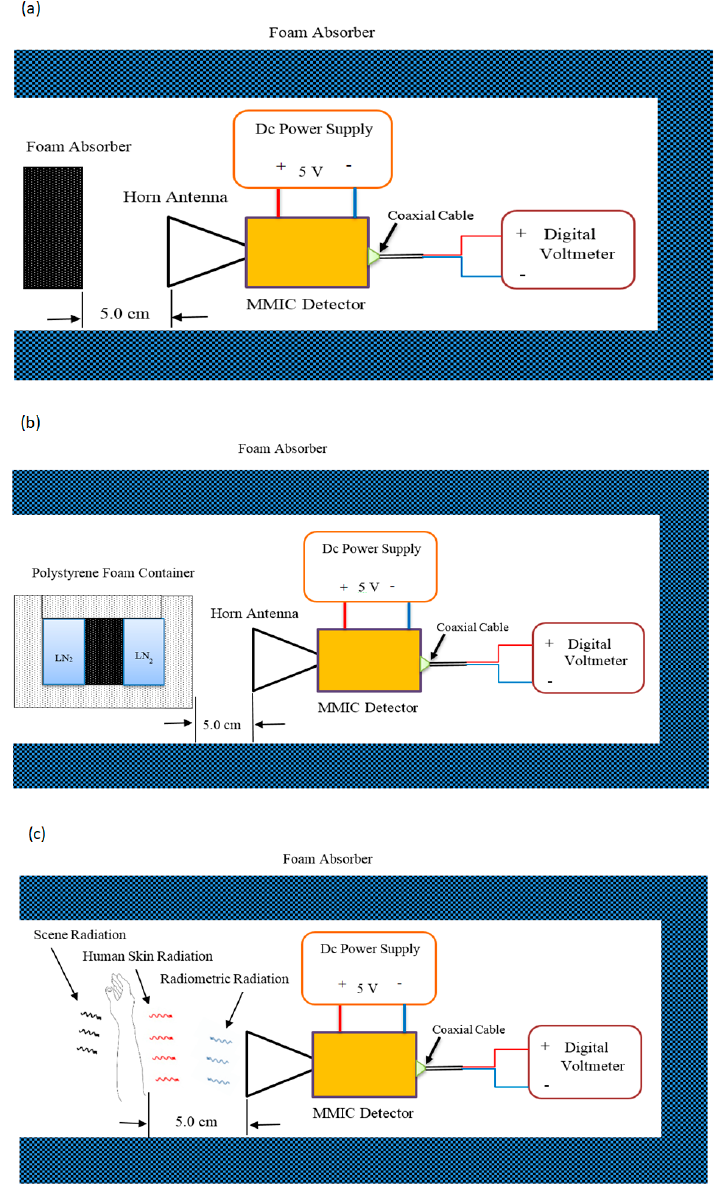
Figure 4. Schematics of the experimental setup inside the walls (blue-grey) of the anechoic chamber, showing the hot ( a ) and the cold ( b ) calibration procedures and the measurement of the skin ( c ).